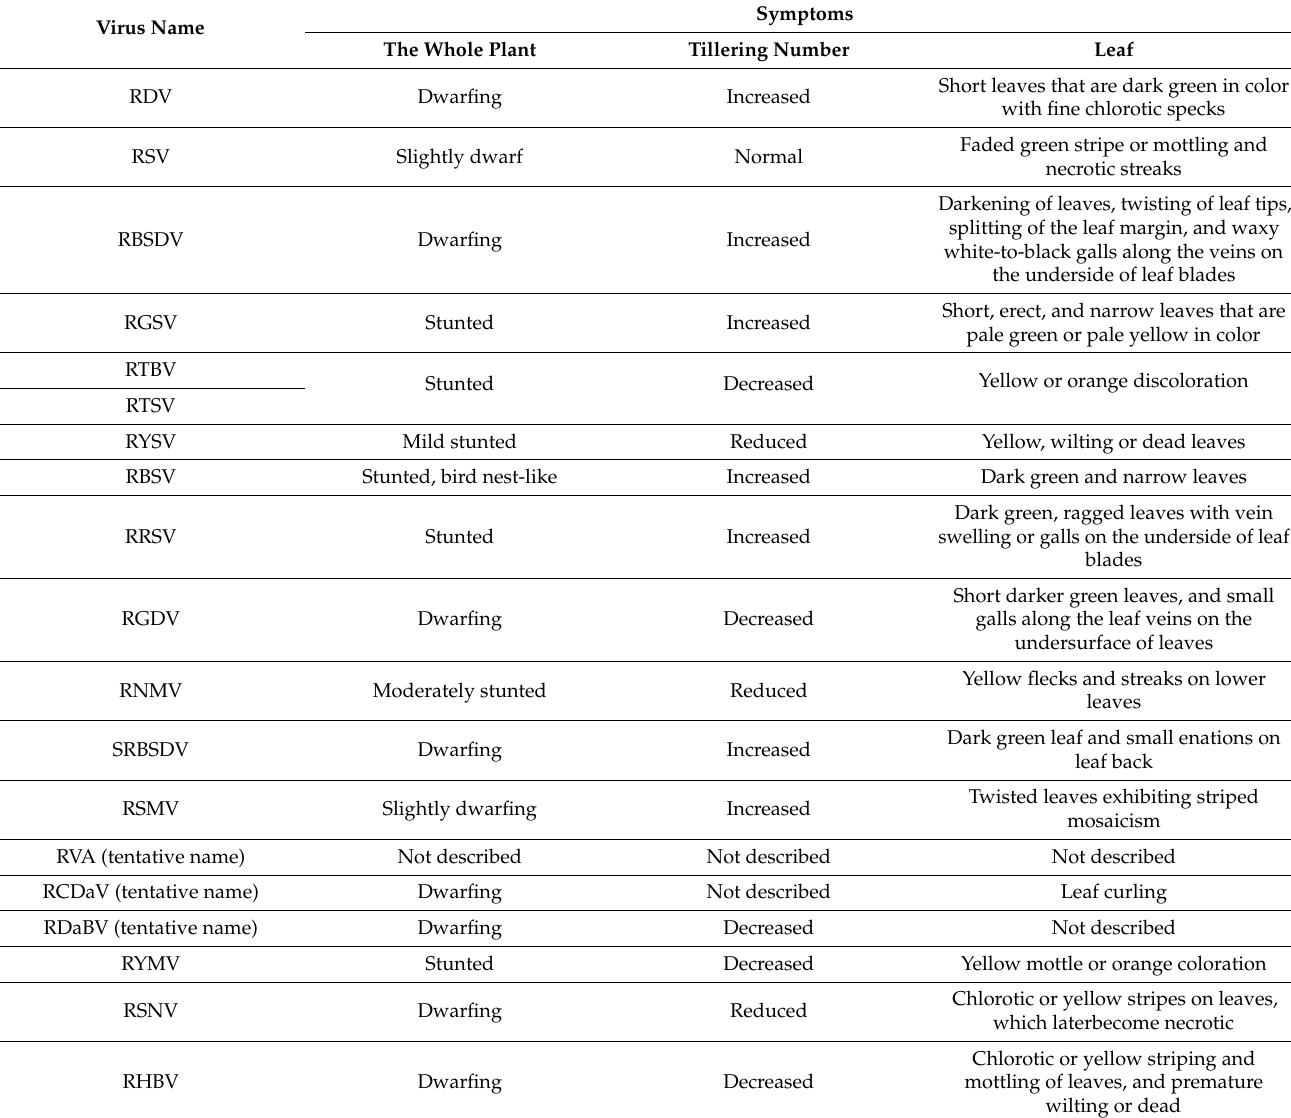
Table 2. Disease symptoms induced by different rice